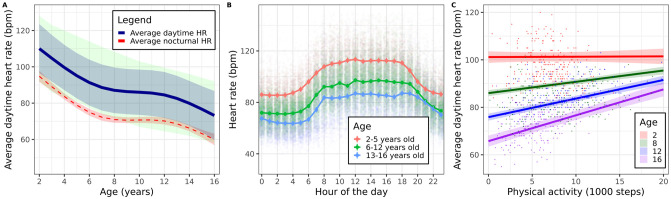
Heart rate.A: average (90% prediction interval) HR during daytime (blue). Average 95% CI nighttime HR (red). Reference values (10th– 90th percentile of HR per age year) are displayed in green. B: Average HR (95% CI) per hour of the day. C: estimated relationship between HR and step count for ages 2, 8, 12 and 16. A limited amount of age years is shown for readability.